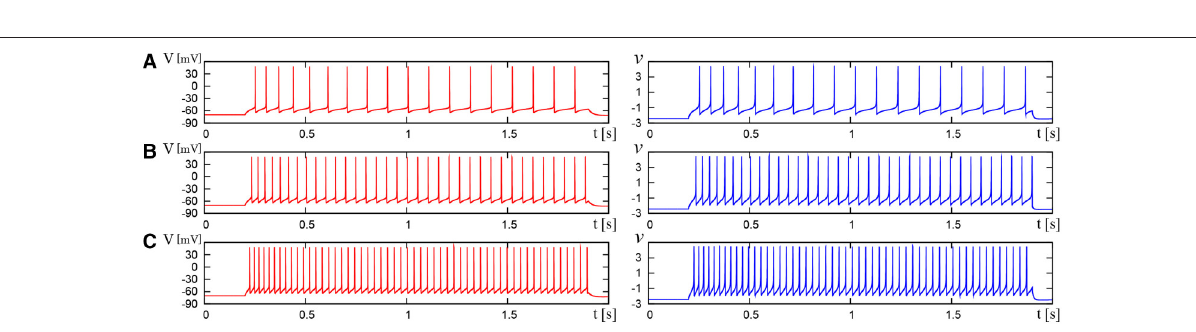
FIGURE 9 | Waveforms of Pospischil and DSSN models, corresponding to a neuron in the FS class. The Pospischils’ model (left) generates periodic spikes in response to a step input rising at t = 0.2 where I stim is (A) 0.78, (B) 0.98, (C) 1.22 nA. The DSSN model (right) generates periodic spikes in response to a step input rising at t = 0.2 where I stim is (A) 2.7, (B) 2.95, (C) 3.25.